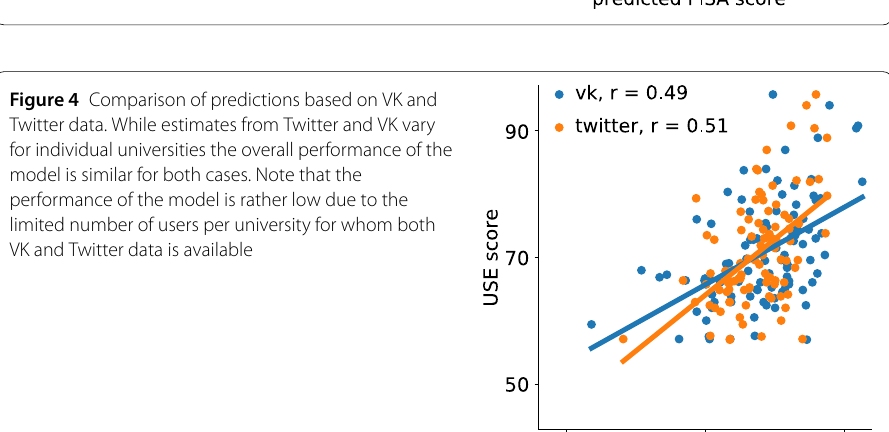
Figure 3 Correlation between the predicted and real performance of schools and universities. Pearson’s correlation coefficients between predicted school scores and the USE scores of their graduates were computed for Saint-Petersburg ( a ), Samara ( b ) and Tomsk ( c ). The correlation between predicted university scores and the USE scores of their enrollees was also computed for the 100 largest Russian universities ( d )